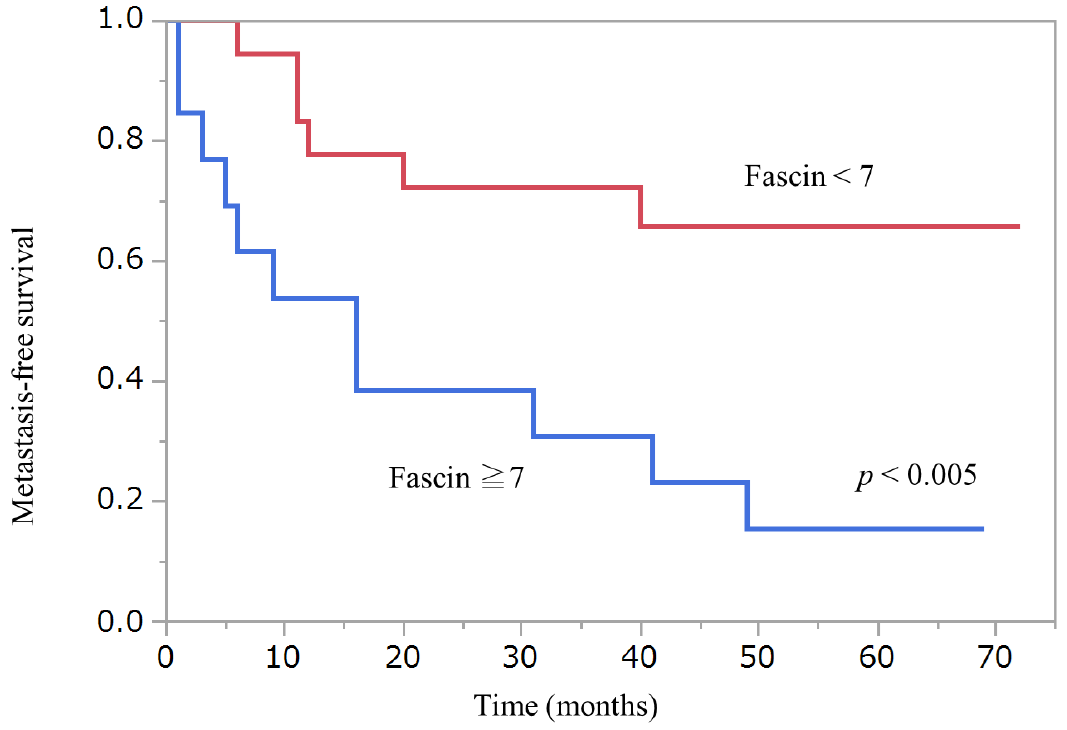
Figure 4. Kaplan–Meier curve and recurrence-free survival distribution between Fascin and Figure 4. Kaplan – Meier curve and recurrence-free survival distribution between Fascin and metas- tasis. Table 5. Tumor locations classified according to the WHO categories.